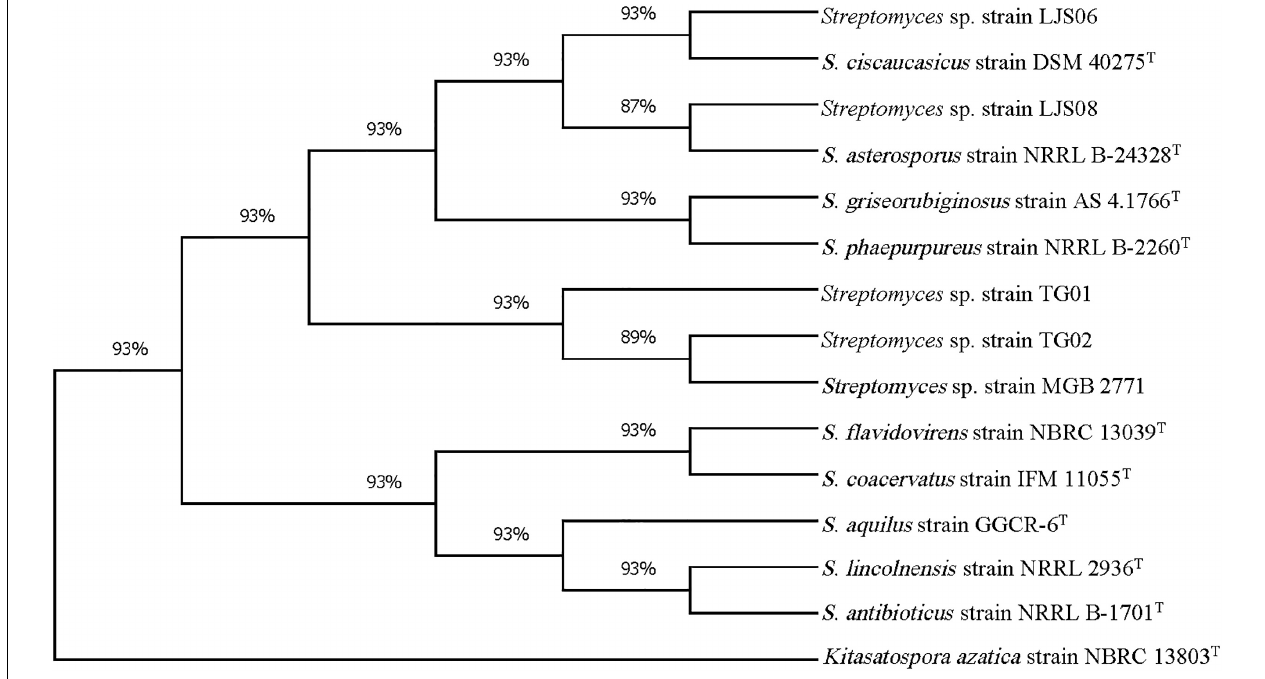
FIGURE 3 | Phylogenetic tree of Streptomyces strains TG01, TG02, LJS06, and LJS08 based on 16S rRNA sequences. The tree was constructed using the maximum likelihood method with Tamura-3- parameter model and 1,000 bootstrap replicates in MEGA X. Kitasatospora azatica strain NBRC 13803 T was used as an